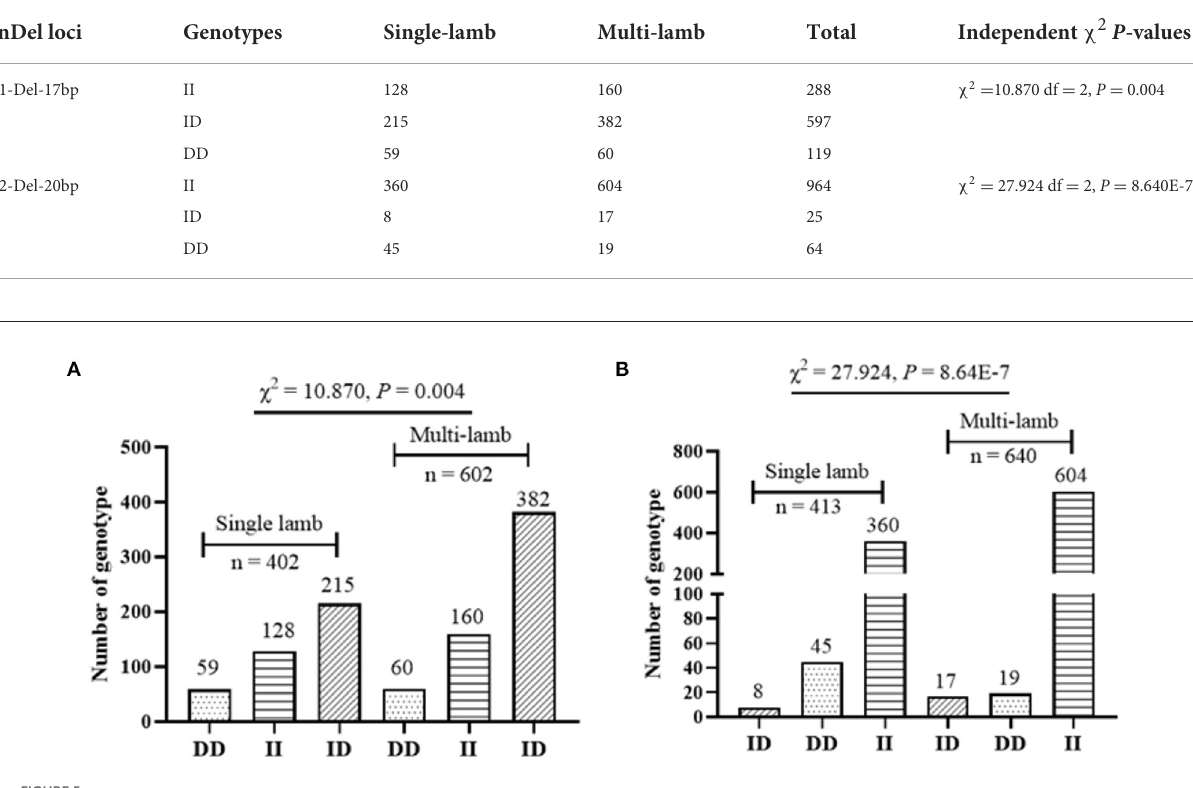
FIGURE5 Genotype distribution between mothers of single-lamb and multi-lamb in SBWC goats; ( A) P1-Del-17bp; (B)